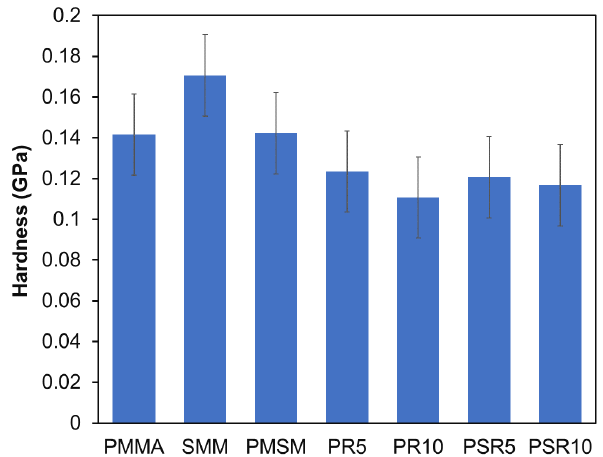
Figure 5. Hardness of the pressed matrix resins, PMMA/PR blends, and PMMA/SMM/PR blends.